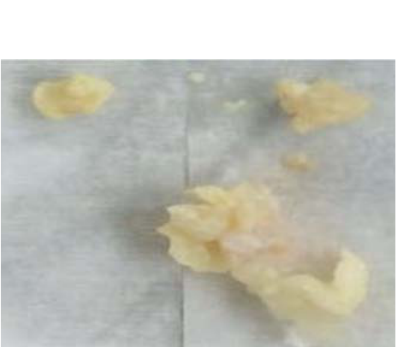
Figure 4. Hematoxylin and Eosin 4× and 40× images of the